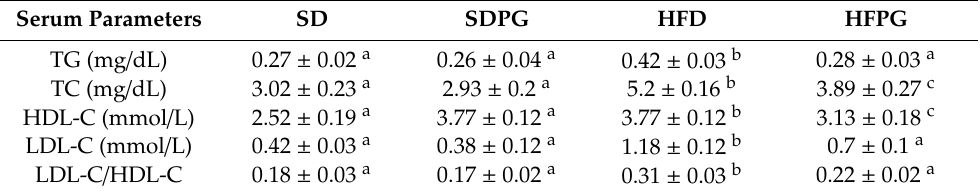
Table 1. Serum TC, LDL-C, HDL-C levels and LDL-C / HDL-C ratio.